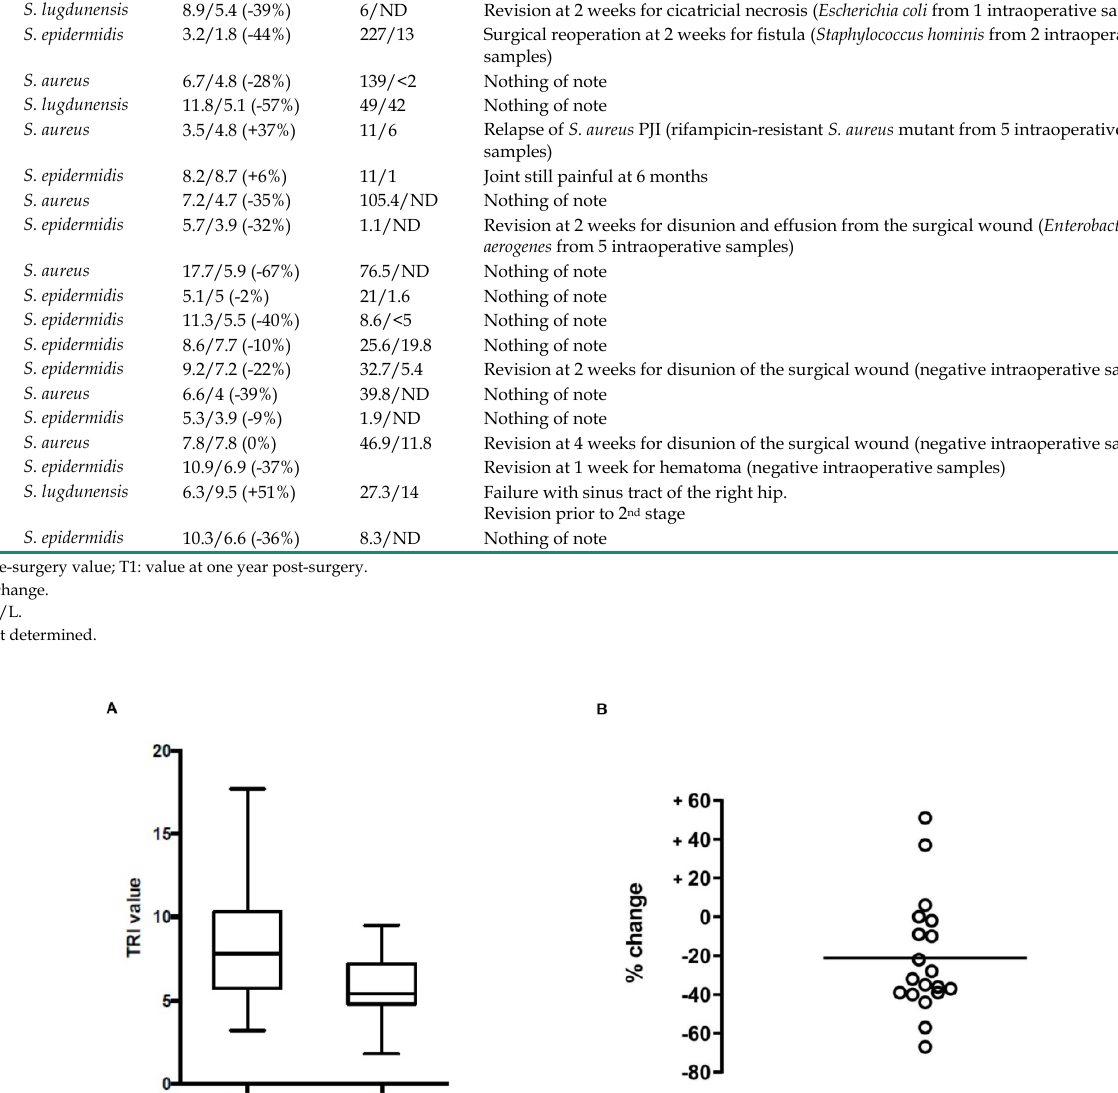
Table 2. Kinetics of antibody response and clinical follow-up. Case n° Organism